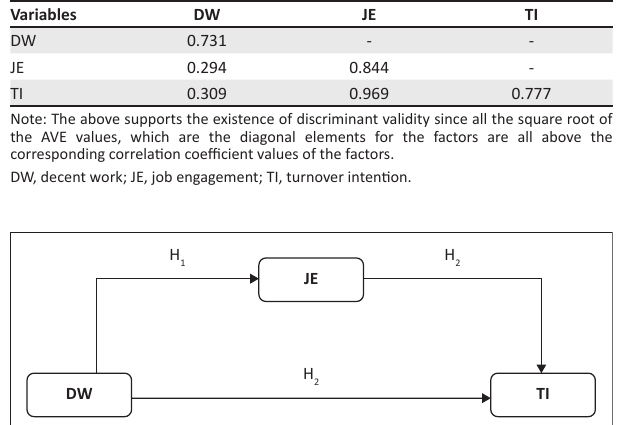
TABLE 3: Inter-construct correlations.